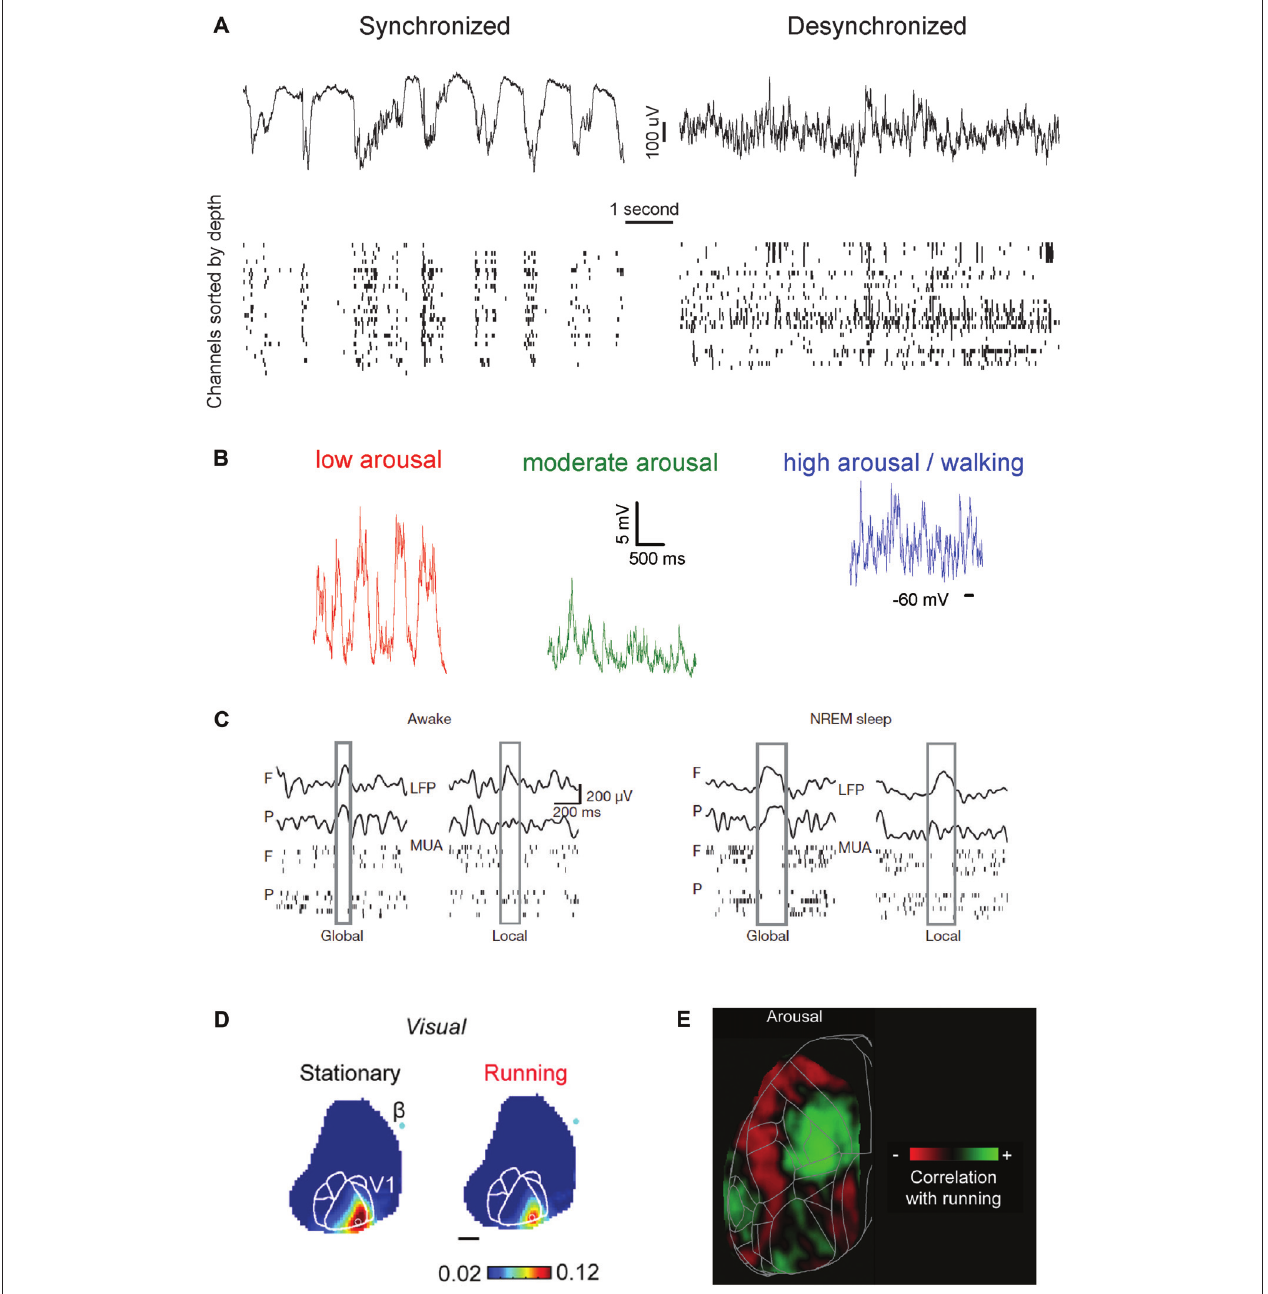
FIGURE 1 | An updated definition of brain states. (A) Brain states have traditionally been distinguished based on the characteristic of population-level oscillatory dynamics present within a behaviorally-defined homogeneous period. Left, top: local field potential (LFP) trace present in mouse visual cortex during isoflurane anesthesia. LFP activity is characterized by oscillatory dynamics with a strong power in slow frequencies (0.5–4 Hz). Left, bottom: at the neuronal level, isoflurane anesthesia determines the alternation of periods of spiking and silence which are synchronous throughout cortical areas, and in phase with the co-occurring LFP oscillations. Right: same as left panel, for activity typical of wakefulness. Note the disappearance of slow frequency oscillations at the LFP level and the overall loss of synchrony for neuronal activity. (B) Recent studies have shown that, within wakefulness, much more variability is present than previously thought. In periods characterized by a low arousal level (left) neuronal activity (here shown in terms of intracellular membrane potential traces) displays patterns indistinguishable from those present during Non-REM sleep or anesthesia. As the arousal level increases, or if a period of activity—locomotion—occurs (center, right) activity becomes more and more desynchronized. Wakefulness can thus be subdivided in several micro-states, with markedly different properties. Adapted from McGinley et al. (2015b), permission to reproduce has been obtained from the publisher. (C) During Non-REM sleep and forms of non-dissociative (e.g., isoflurane) anesthesia UP and DOWN states normally occurs globally, i.e., involving the whole thalamocortical system. However, UP/DOWN states can also be local events, involving one a set